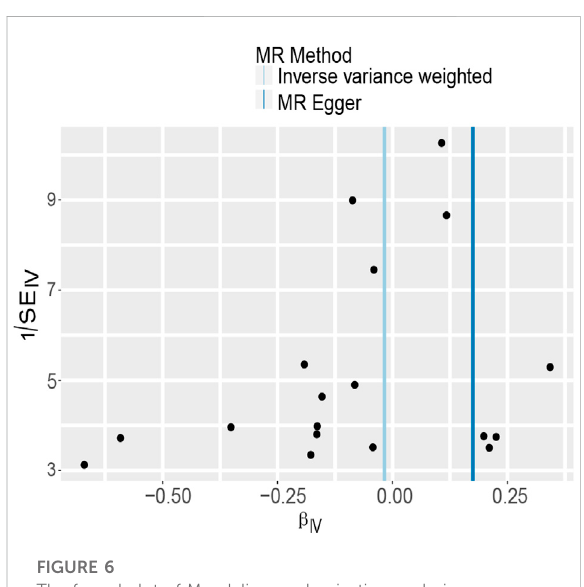
FIGURE 6 The funnel plot of Mendelian randomization